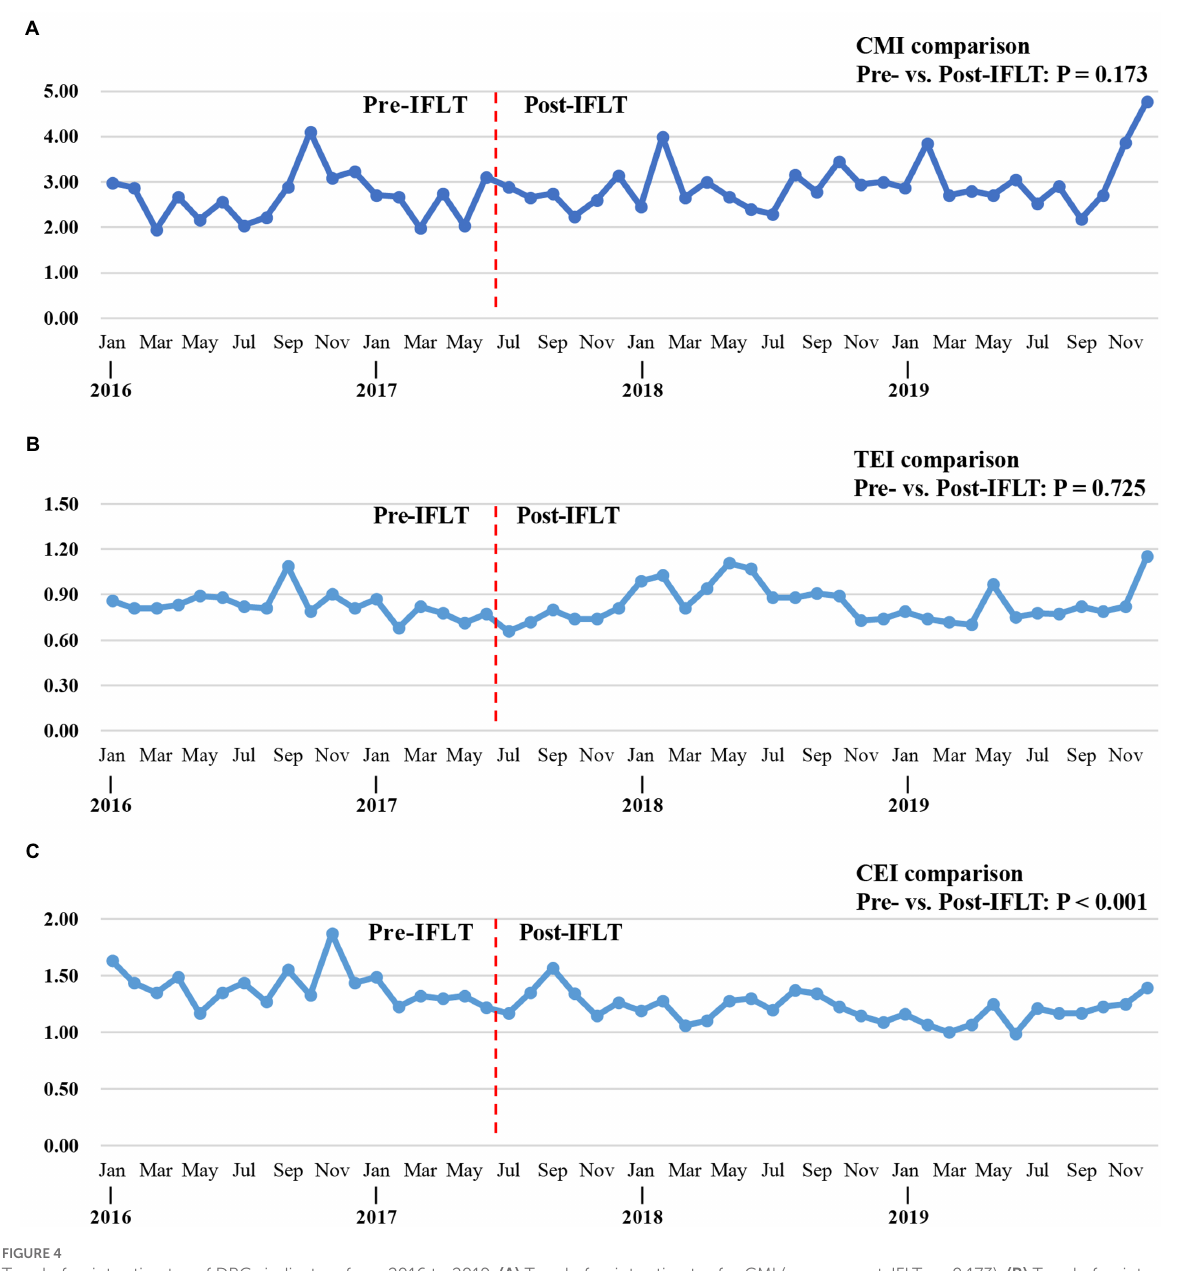
FIGURE 4 Trend of point estimates of DRGs indicators from 2016 to 2019. (A) Trend of point estimates for CMI (pre- vs. post-IFLT, p = 0.173). (B) Trend of point estimates for TEI (pre- vs. post-IFLT, p = 0.0.725). (C) Trend of point estimates for CEI (pre- vs. post-IFLT, p < 0.001). DRGs, diagnosis-related groups. CMI, Case Mix Index. TMI, time efficiency index. CEI, charge efficiency